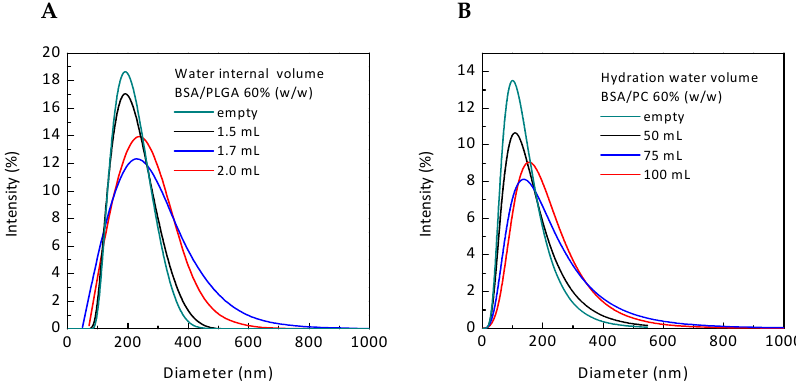
Figure 1. Representative particle size distribution of ( A ) PNPs and ( B ) NLPs. PNPs: polymeric nanoparticles, NLPs: nanoliposomes.